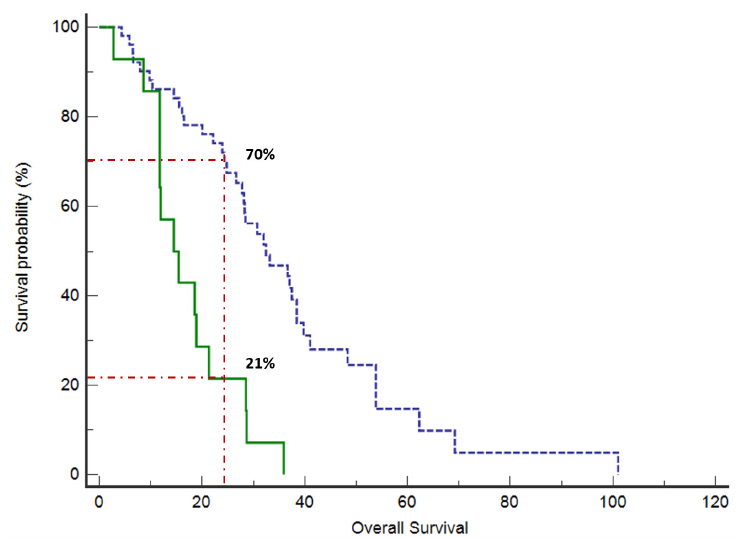
Figure 2. Median OS was 30.7 months (95%CI 27.8 to 101) in patients with low CD44 expression (blue line, dashed) versus 14.5 months (95%CI 11.7 to 35.9) in high CD44 expression group (green line, continuous) ( p = 0.0001). The proportion of patients alive at 24 months was 70% in the low CD44 expression group versus 21% of high CD44 expression patients ( p = 0.0001). Patients involved in our analysis received first- and second-line chemotherapy treat- ment based on the patient’s clinical features, tumor-related biological characteristics,